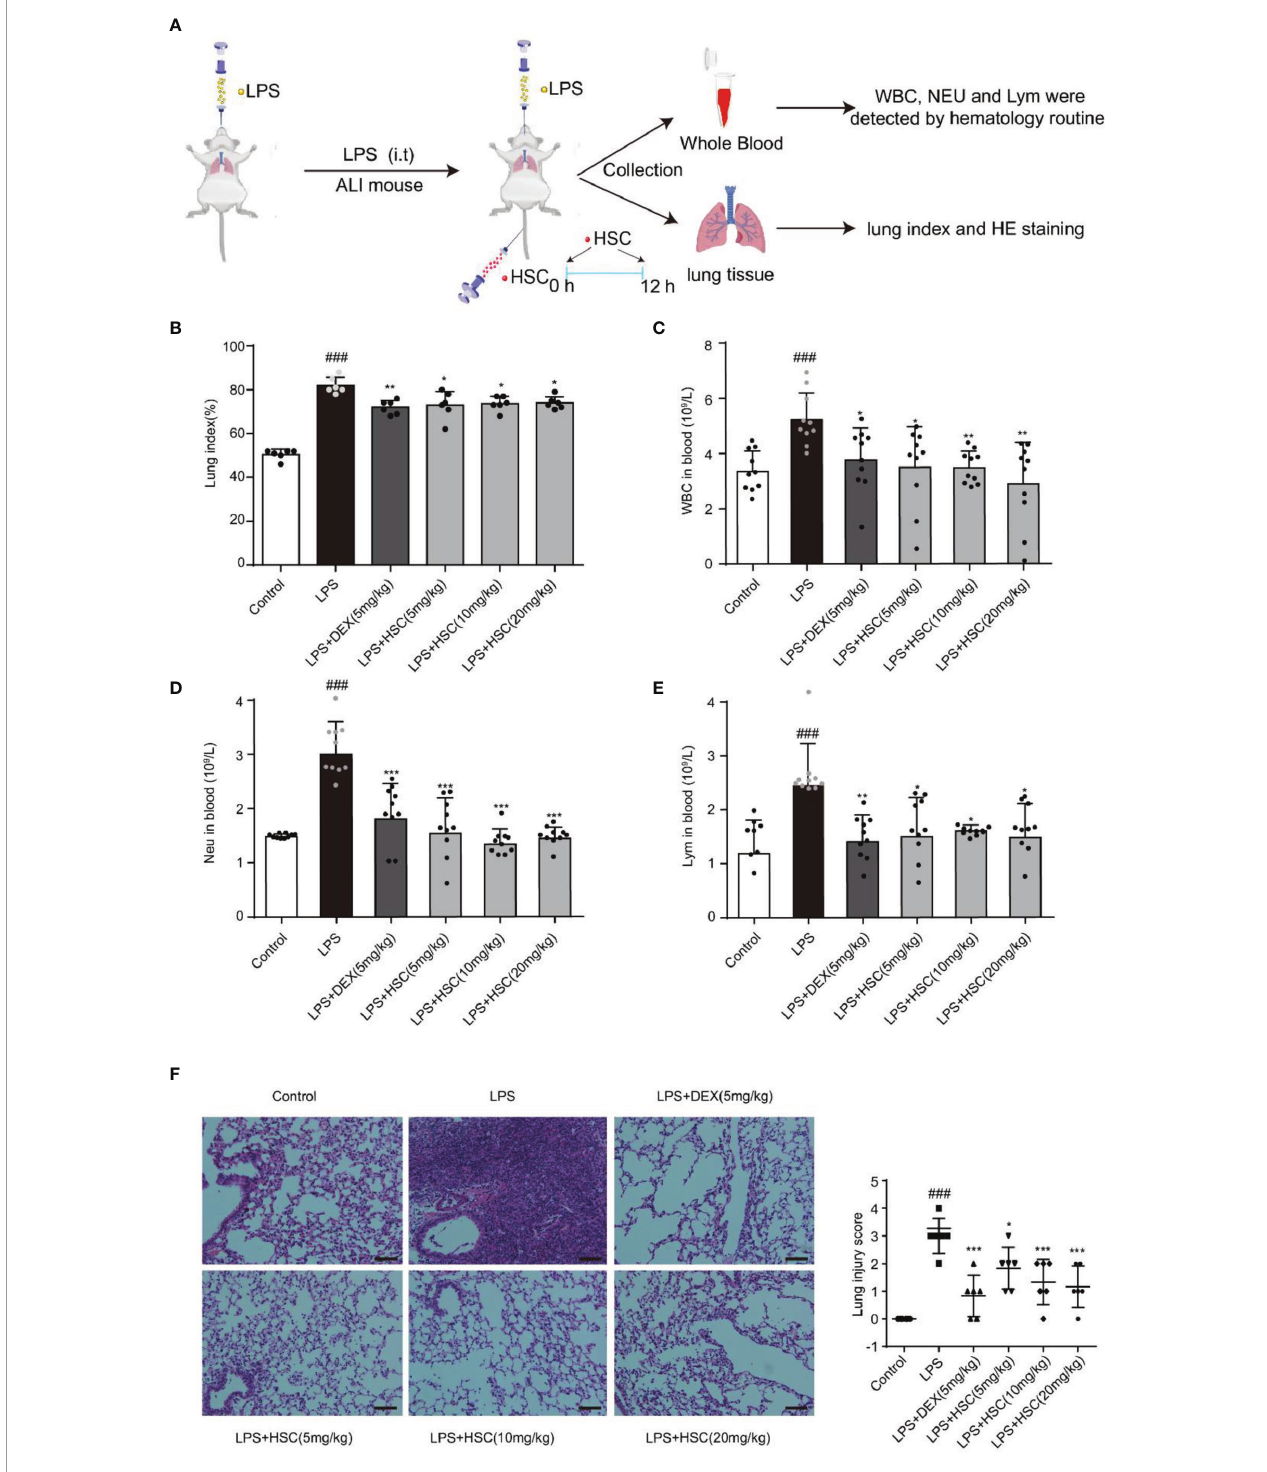
FIGURE 8 | HSC ameliorated LPS-induced ALI in mice. (A) The mice were treated with LPS (4mg/kg, i.t.). After LPS injection, mice were treated with HSC at 0 and12 h, and the corresponding indexes were measured 24 h later. (B) Lung index (n=6); (C) White blood cells (WBC), (D) neutrophil and (E) lymphocyte counts in the blood, which were determined by an auto hematology analyzer (n=10), (F) Lung histopathology was assessed via H&E staining assay at 24 h after LPS challenge (200×) (n=6); ### P < 0.001 compared to control alone group; * P < 0.05, ** P < 0.01, and *** P < 0.001 versus the LPS